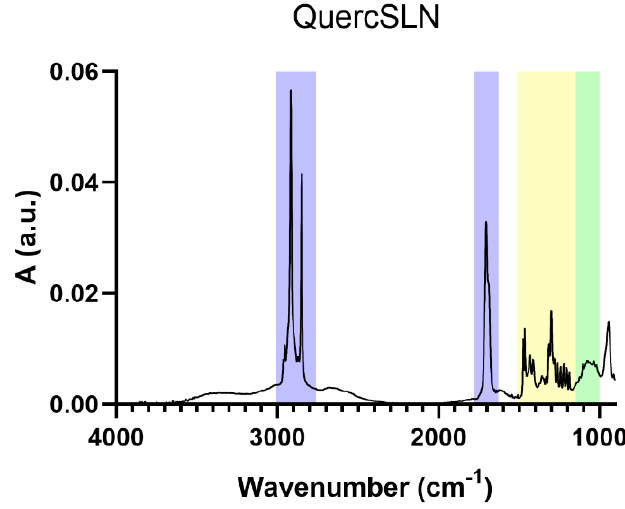
Figure 5. IR spectrum of QuercSLN.